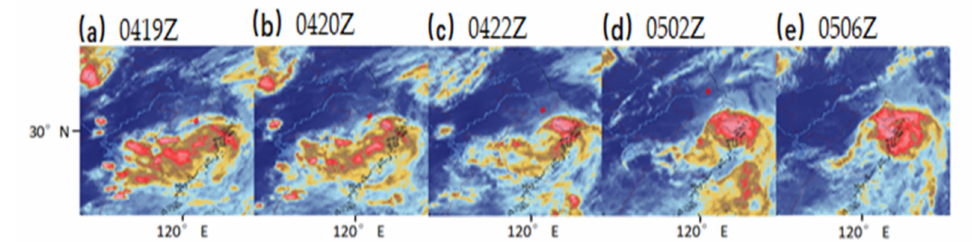
Figure 3. FY-4A infrared satellite cloud image from 19:00 BT 4 to 06:00 BT 5 August 2020 (the red symbol in the figure is the position of the typhoon at the same time), ( a ) 19:00 BT 4, ( b ) 20:00 BT 4,